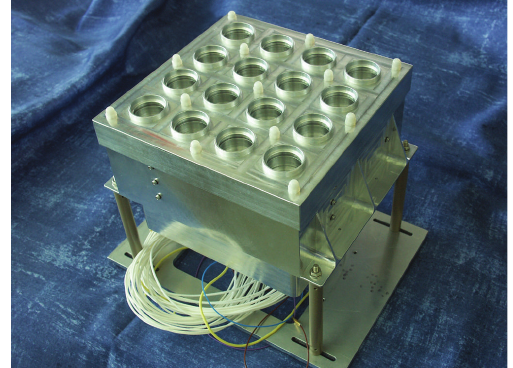
Figure 4: Breadboard thruster (4 × 4 LIMS).